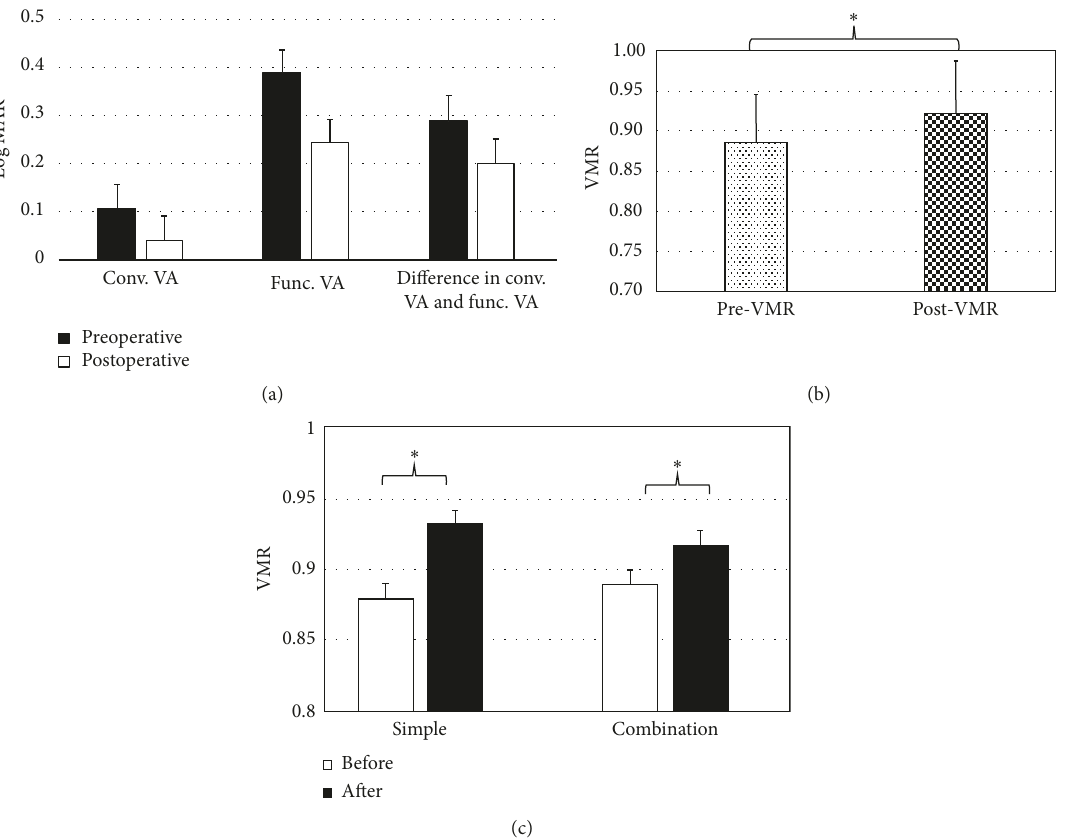
Figure 3: Changes in visual acuity. Comparison of conventional visual acuity, functional visual acuity, and the difference in conventional visual acuity and functional visual acuity between preoperative and postoperative conditions (a); change in the VMR after Trabectome surgery (b); and comparison of changes in the VMR between Trabectome surgery only and Trabectome surgery with phacoemulsification with intraocular lens insertion (c). ∗ P < 0 . 05, paired t -test; conv., conventional; func., functional; VA: visual acuity; MAR: minimum angle resolution; VMR: visual maintenance